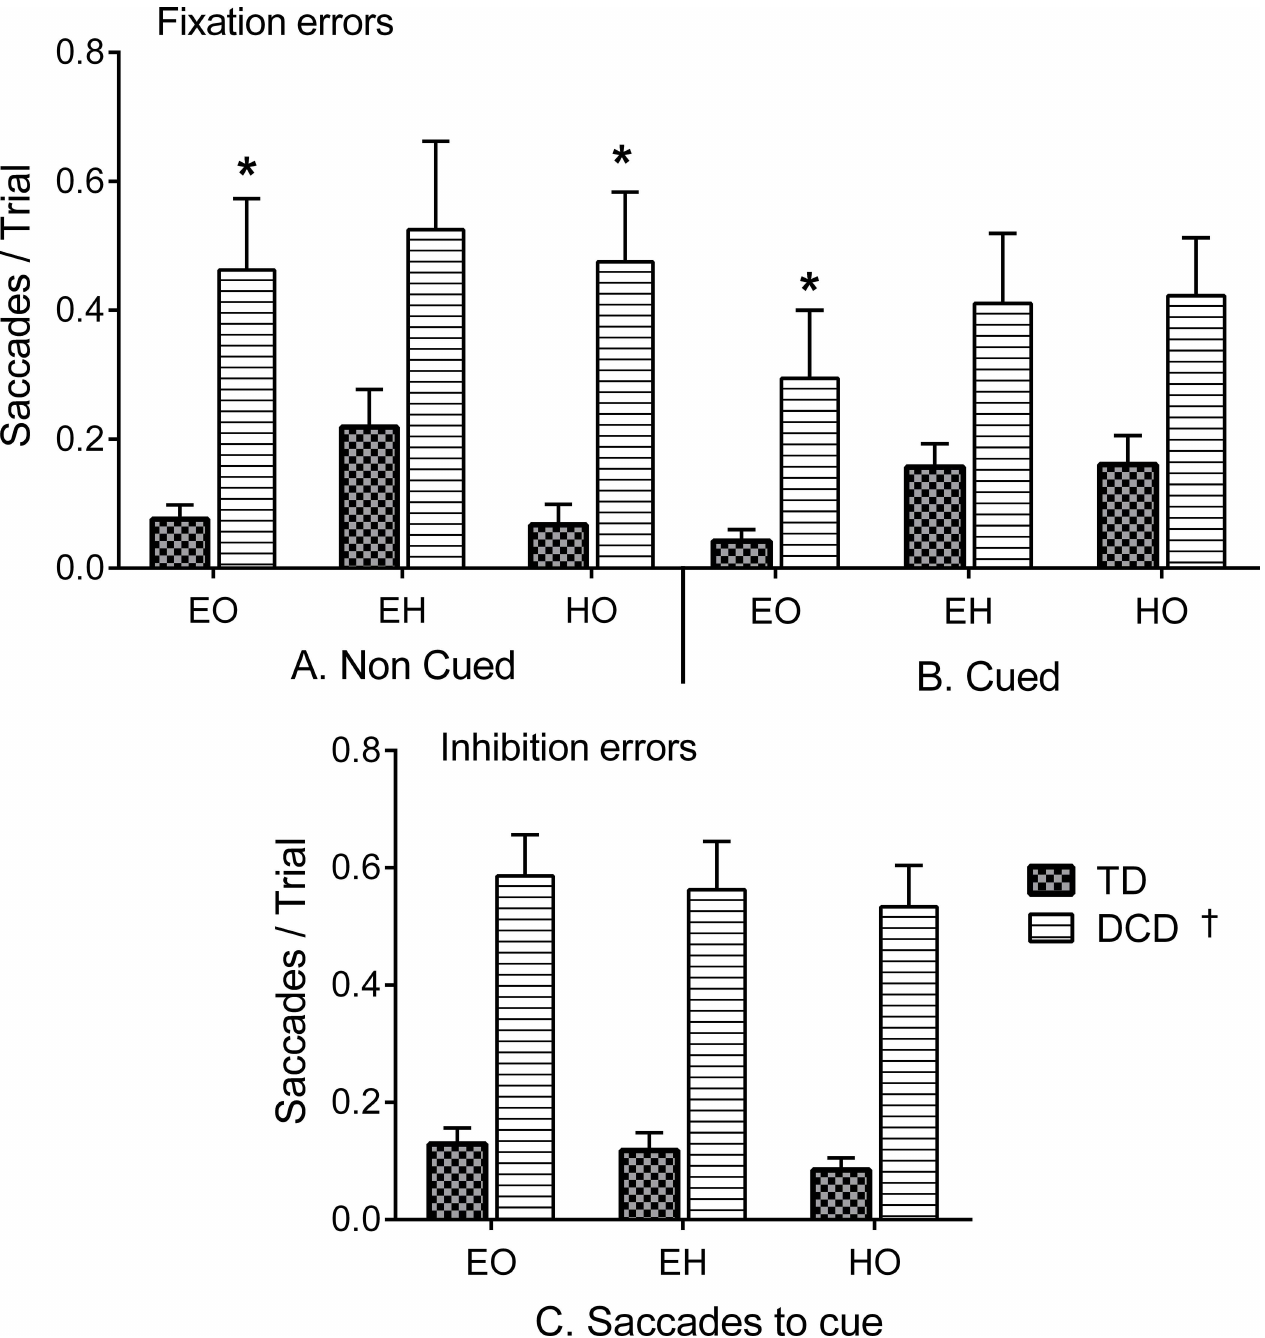
Fig 3. Mean (and SEM) number of saccades per trial ratios for Non-Cued (A, left) and Cued (B, right) across EO, EH and HO blocks. The graph shows the ratio of larger saccades away from fixation, which was higher in the DCD compared to the TD group (DCD vs. TD, * ). Lower panel. Mean number of saccades per trial (and SEM) during the presentation of the cue (250 ms) across Cued (EO, EH and HO) conditions (C). Overall, childrenwith DCD exhibitedgreater number of saccades and thus, more inhibitionerrors compared to the TD group (DCD vs. TD,